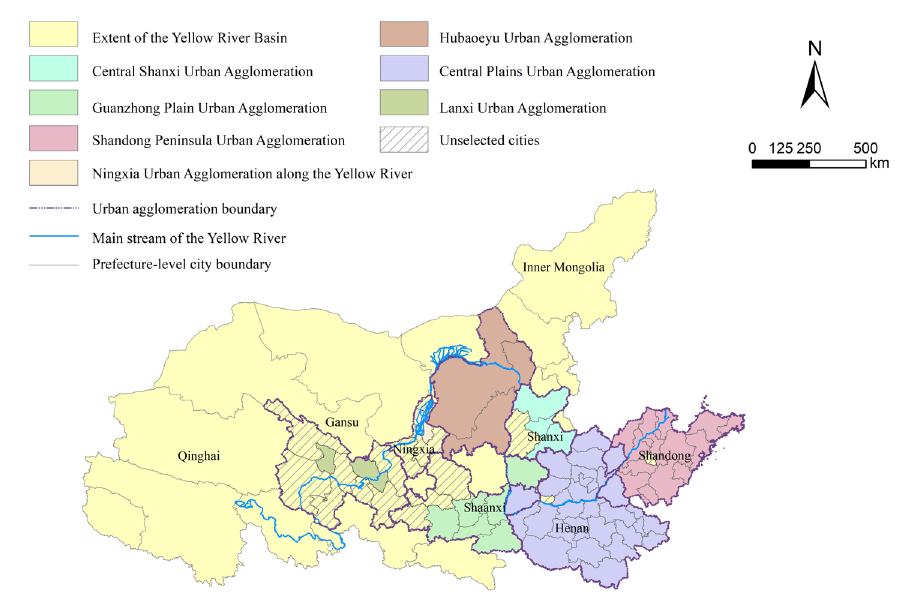
Figure 1. Distribution of urban agglomerations in the Yellow River basin, China.